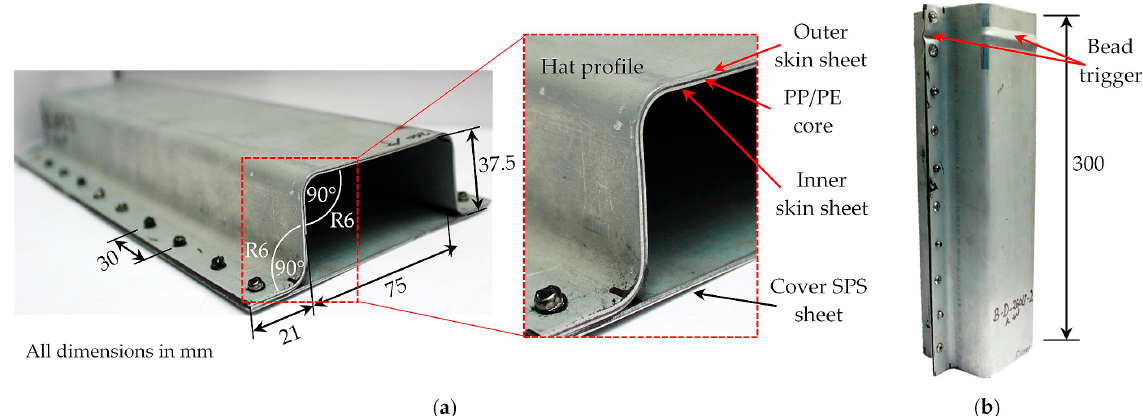
Figure 3. ( a ) Top-hat and ( b ) double-hat crashboxes.